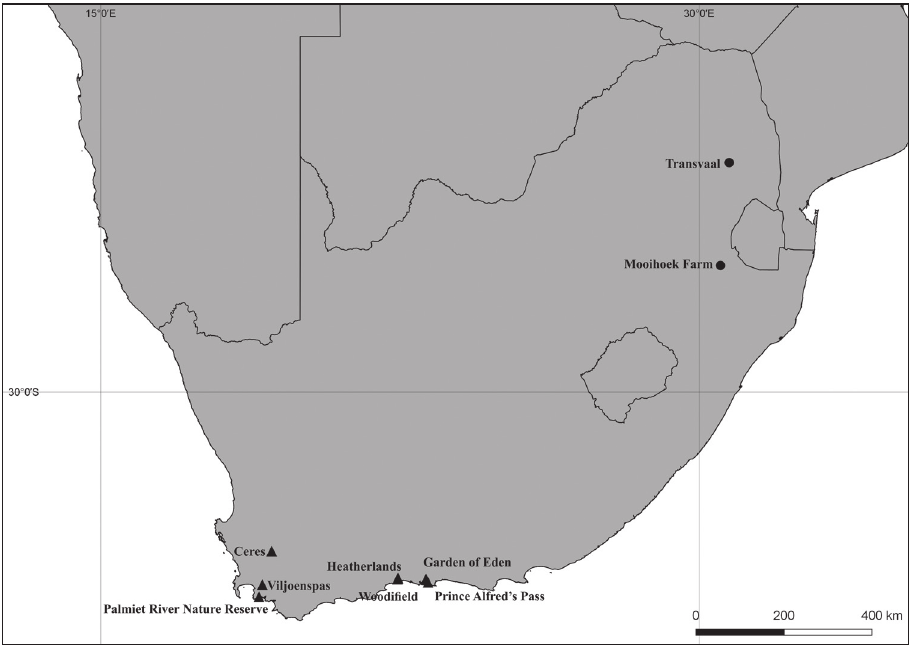
Figure 13. Known distribution of southern African species of the bilamellatus -group: Cis mooihoekite sp. n. (black circle) and Cis pickeri Lopes-Andrade, Matushkina, Buder & Klass (black